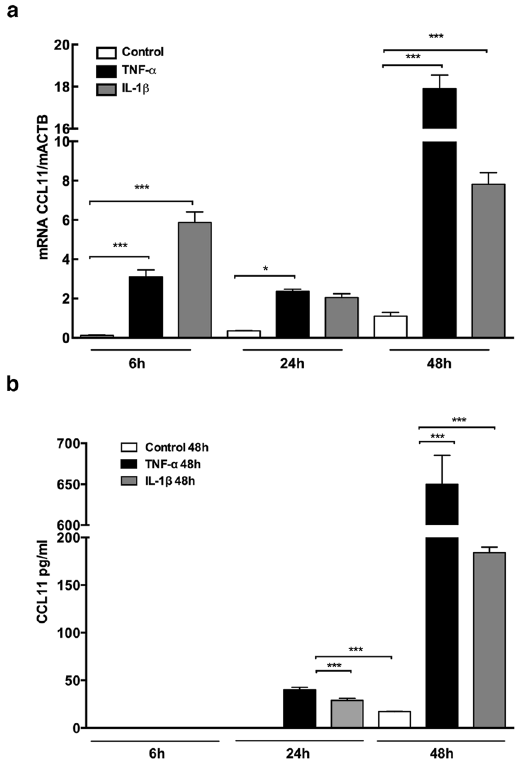
Figure 2. CCL11 mRNA and protein expression in TNF- α and IL-1 β stimulated mouse osteoblasts. ( a ) mRNA expression of CCL11 in non-stimulated and TNF- α or IL-1 β stimulated osteoblasts after 6 h, 24 h and 48 h of incubation. ( b ) CCL11 release measured in medium cultured in absence and presence of TNF- α and IL-1 β after 24 h and 48 h of incubation. Data are expressed as means ±